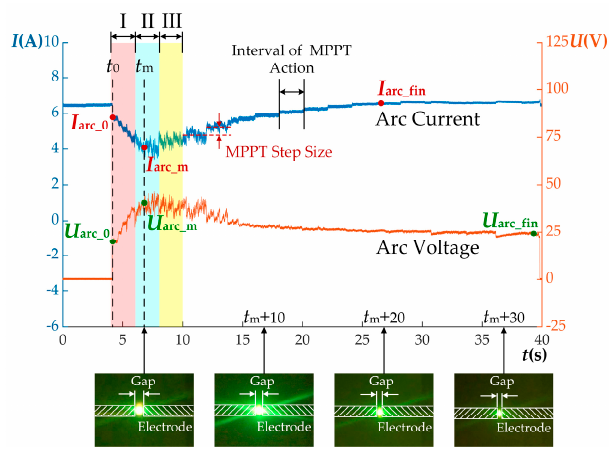
Figure 4. Typical arc voltage and current waveform changes under the action of maximum power point tracking (MPPT) and reduced gap due to the thermal expansion of the